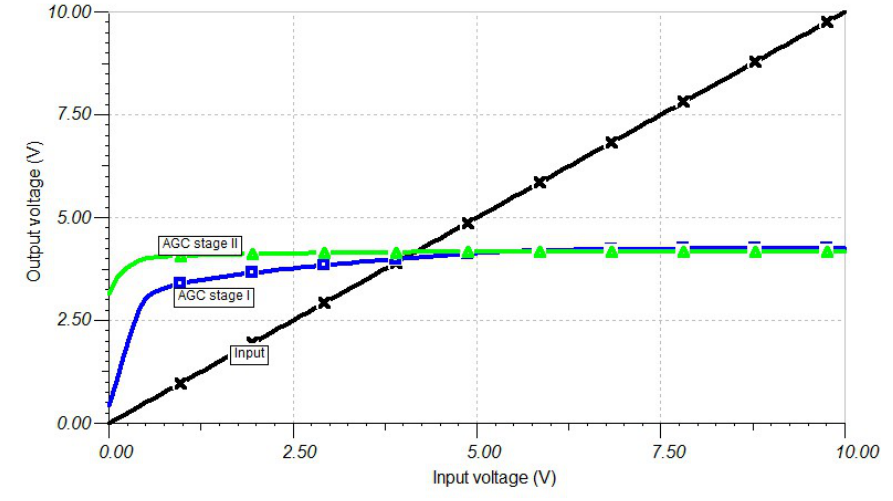
Fig. 8. DC signal characteristic of two stage AGC circuit using IC LM13700 from varied input